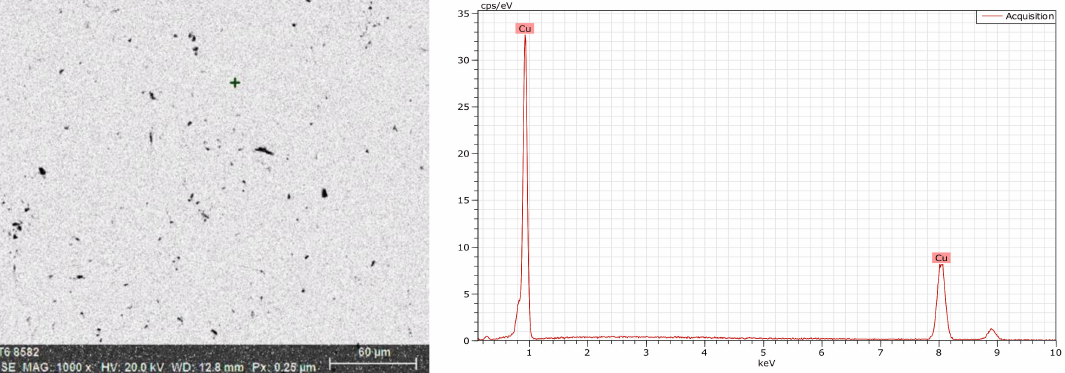
Figure 5. Energy spectrum analysis at the crack-free location.